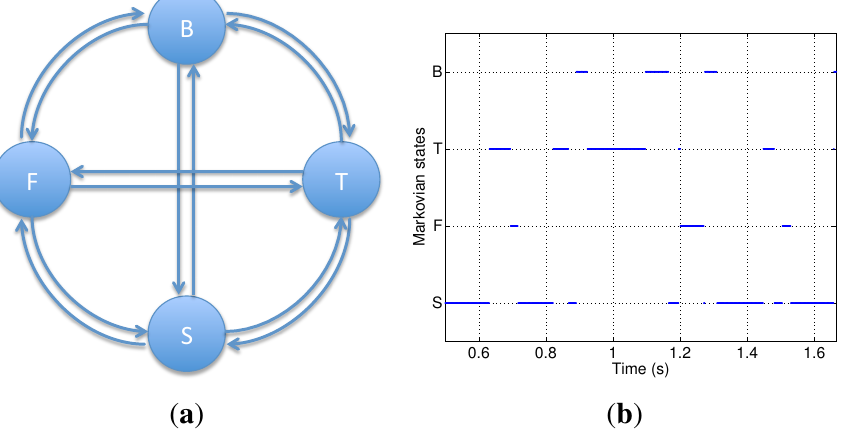
Figure 3. Markovian state jumps and model. ( a ) Markov Jump Linear Systems (MJLS) estimation model; ( b ) Markovian state jumps over one